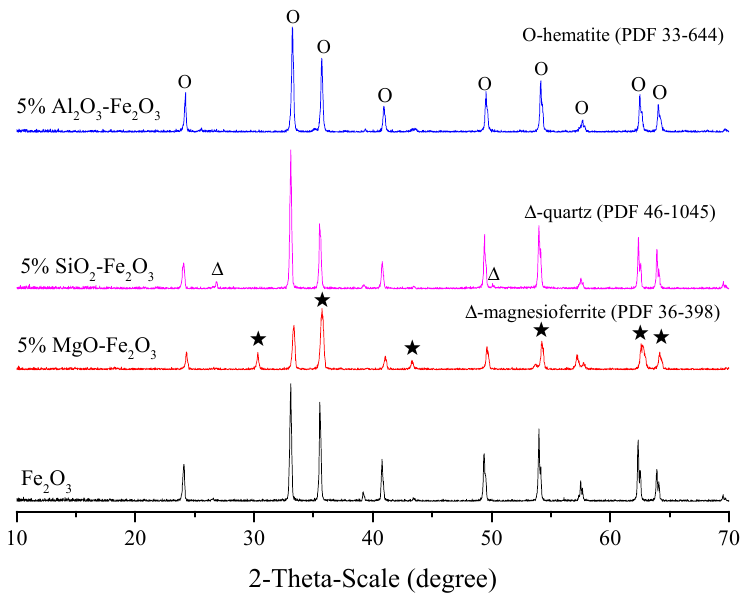
Figure 2. XRD pattern of the preheated samples with different gangue component.